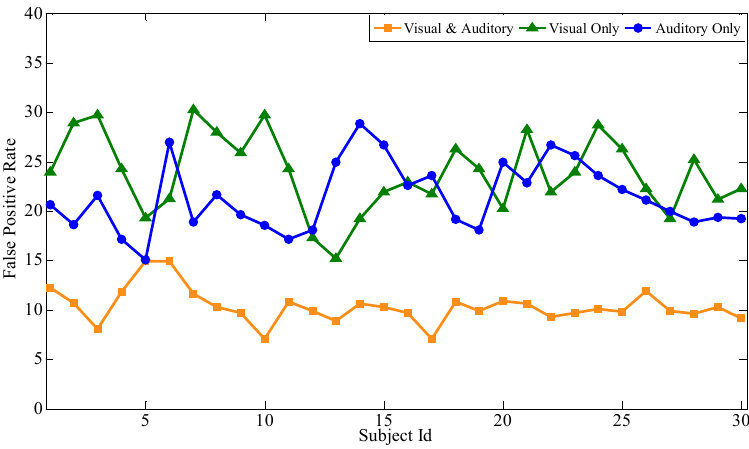
Figure 10. Comparison of the precision rate of the three paradigms.